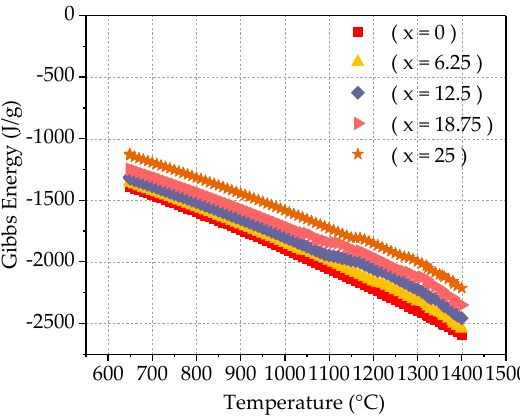
Figure 10. Gibbs free Energy calculation for Fe 25 Cr 25 Ni 25 Ti x Al (25 − x) multi-principal element